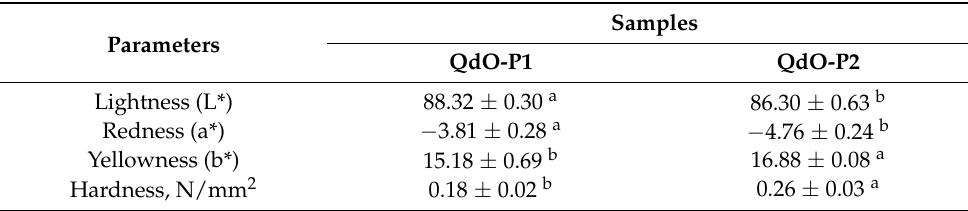
Table 2. Physical parameters of Quadrello di ovino cheeses.